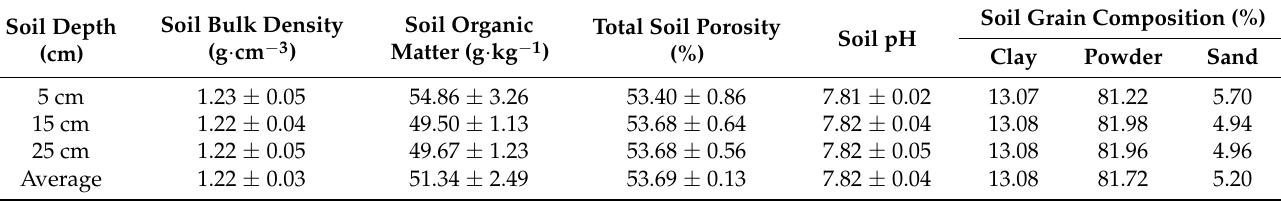
Table 1. Soil properties in the study